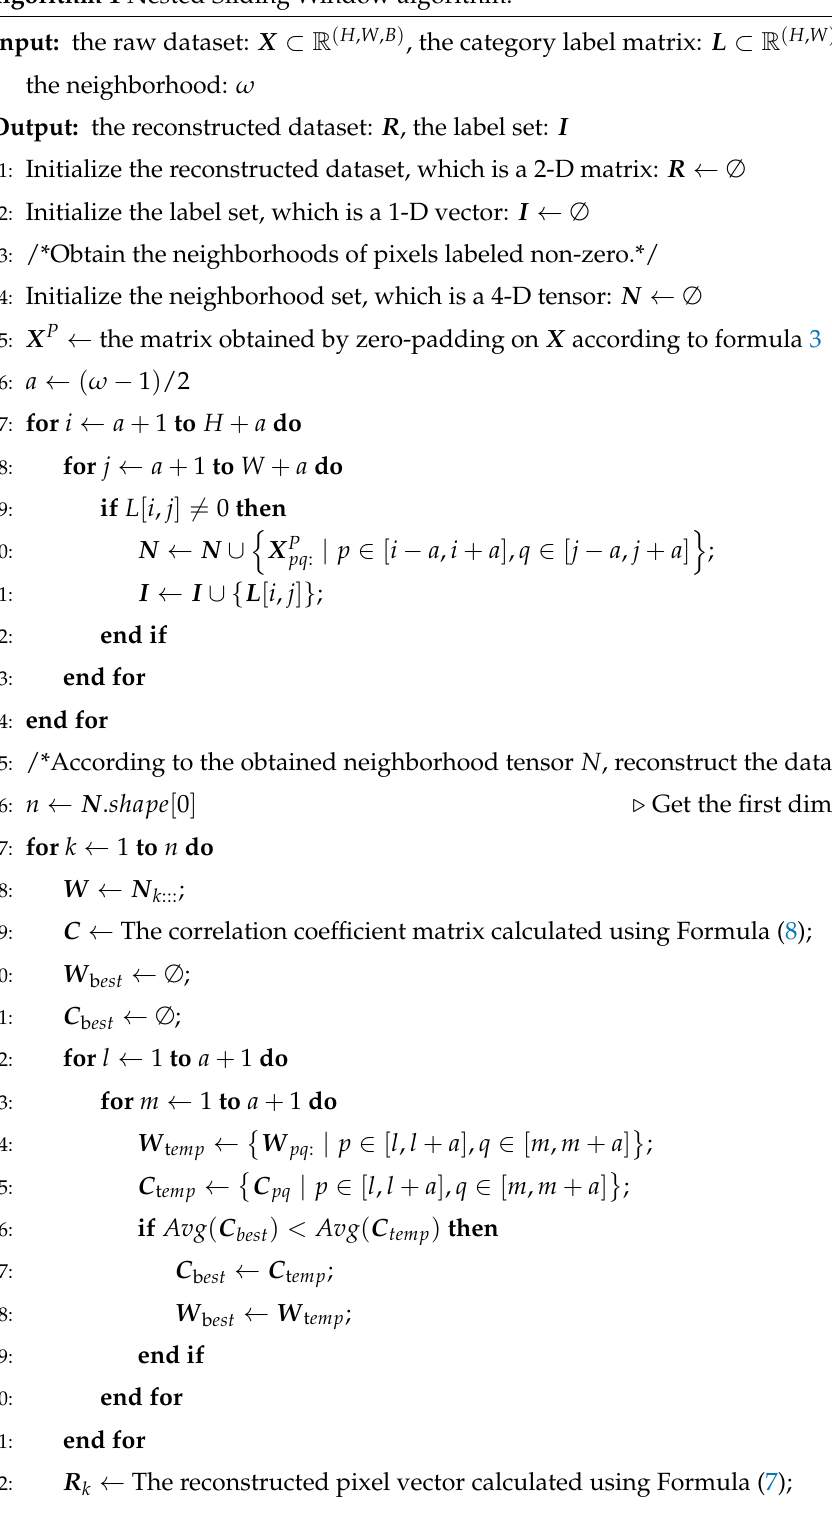
Algorithm 1 Nested Sliding Window